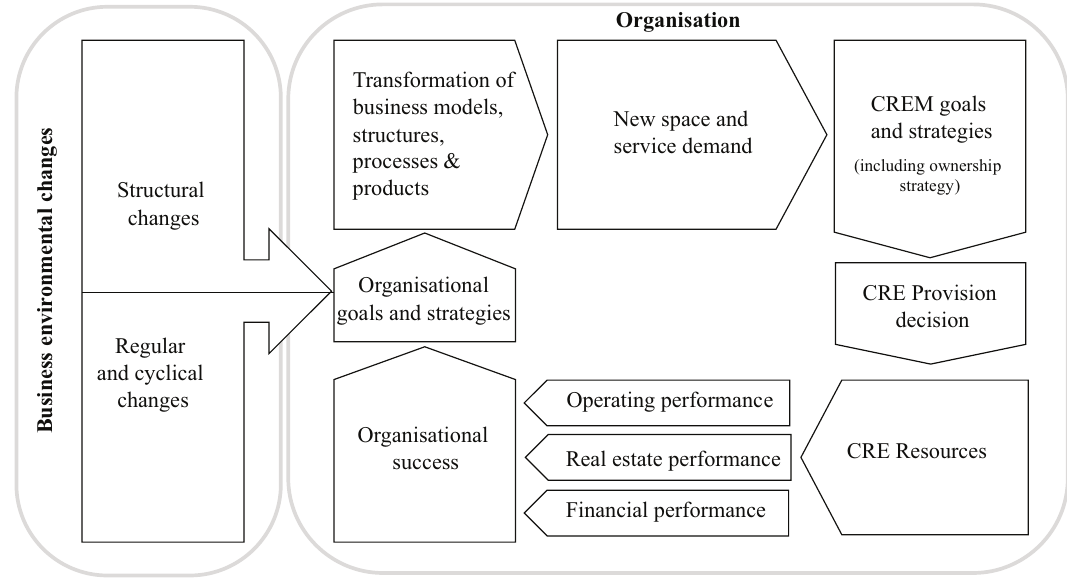
Figure 1. CRE provision as a continuous process of alignment to the business